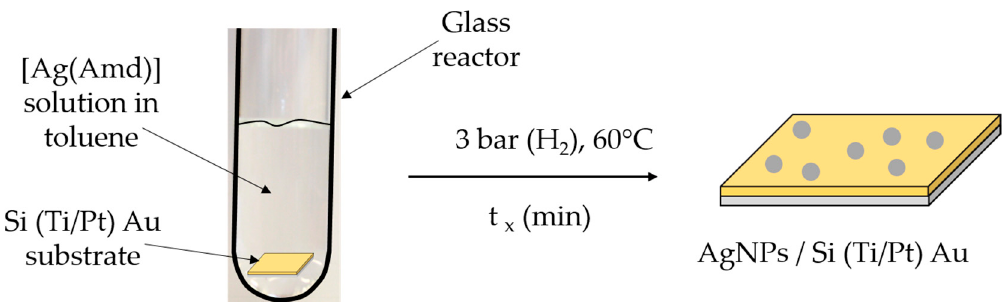
Figure 1. Scheme of the in situ deposition of AgNPs by the direct decomposition of [Ag(Amd)] in solution in the presence of the Si(Ti/Pt)Au substrate.